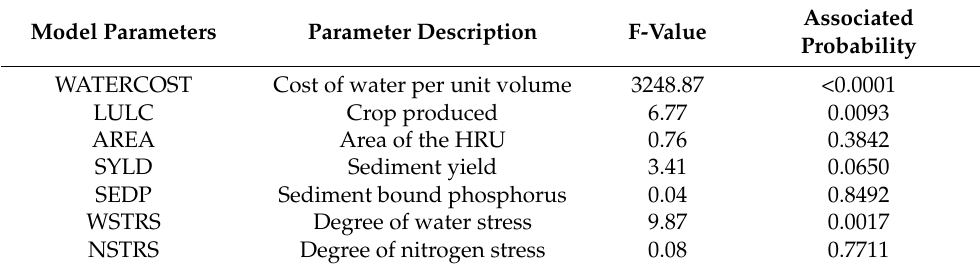
Table 1. Results of analysis of variance (ANOVA) in determining the factors that influence model recommendations for the application or non-application of